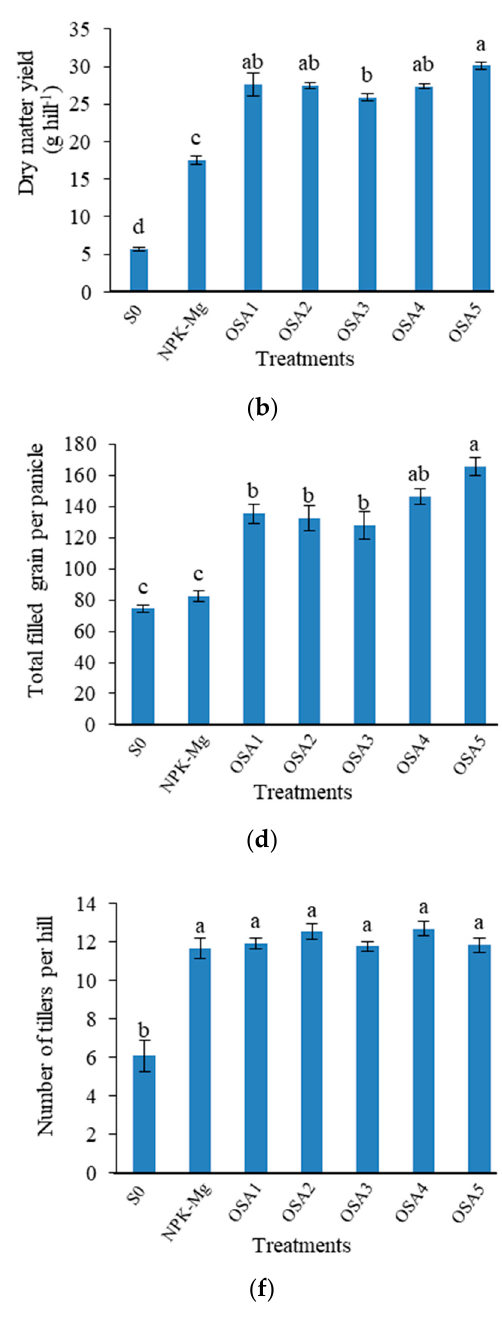
Figure 3. ( a ) Grain yield, ( b ) dry matter yield, ( c ) plant height, ( d ) total filled grain per panicle, ( e ) number of panicles per hill, and ( f ) number of tillers per hill of rice plants in relation to the addition of chemical fertilizers and organic soil amendments after the first cropping cycle. Means with different letters indicate significant difference using Tukey’s test at p ≤ 0.05 and error bars represent standard error.